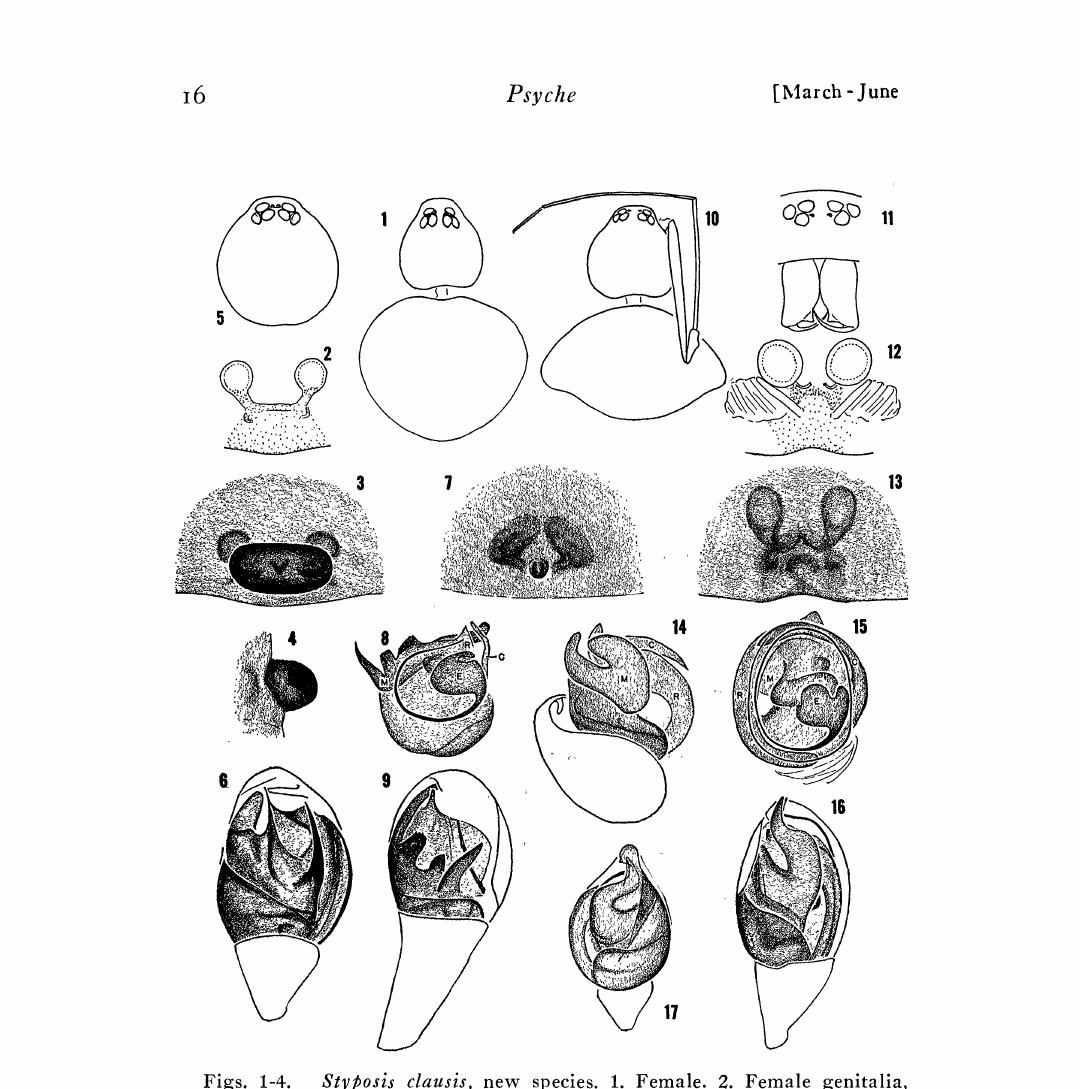
Figs. 1-4. Styosis clausis, new species. 1. Female. 2. Female genitalia, dorsal view. 3. Epigynum. 4. Epigynum from side. Figs. 5-6. S. rancho, new species. 5. Carapace of male. 6. Left palpus. Fig. 7. S. flaescens Simon, epigynum. Figs. 8-9. S. nicaraguesis, new species, palpus. 8. Expanded, ectal view. 9. Ventral view. Figs. 10-17. S. chiceringi, new species. 10. Female. 11. Head of female. 12. Female genitalia, dorsal view. 13. Epigynum. 14. Palpus expanded, subventral view. 15. Palpus expanded, ectal view. 16. Palpus of type. 17. Right palpus of paratype drawn at slightly different